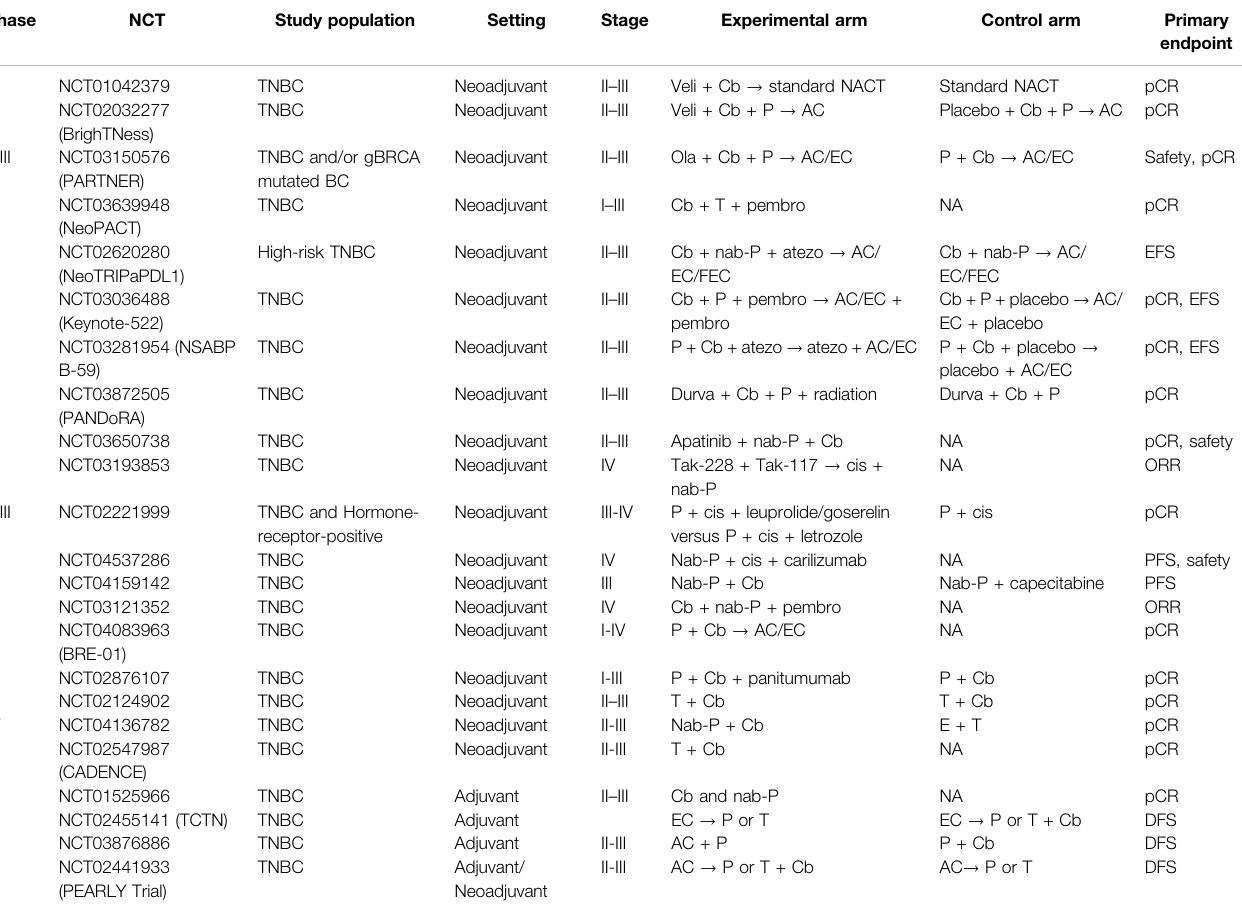
TABLE 3 | Summary of ongoing and recently reported clinical trials with Pt derivatives and taxane combinations in triple-negative breast